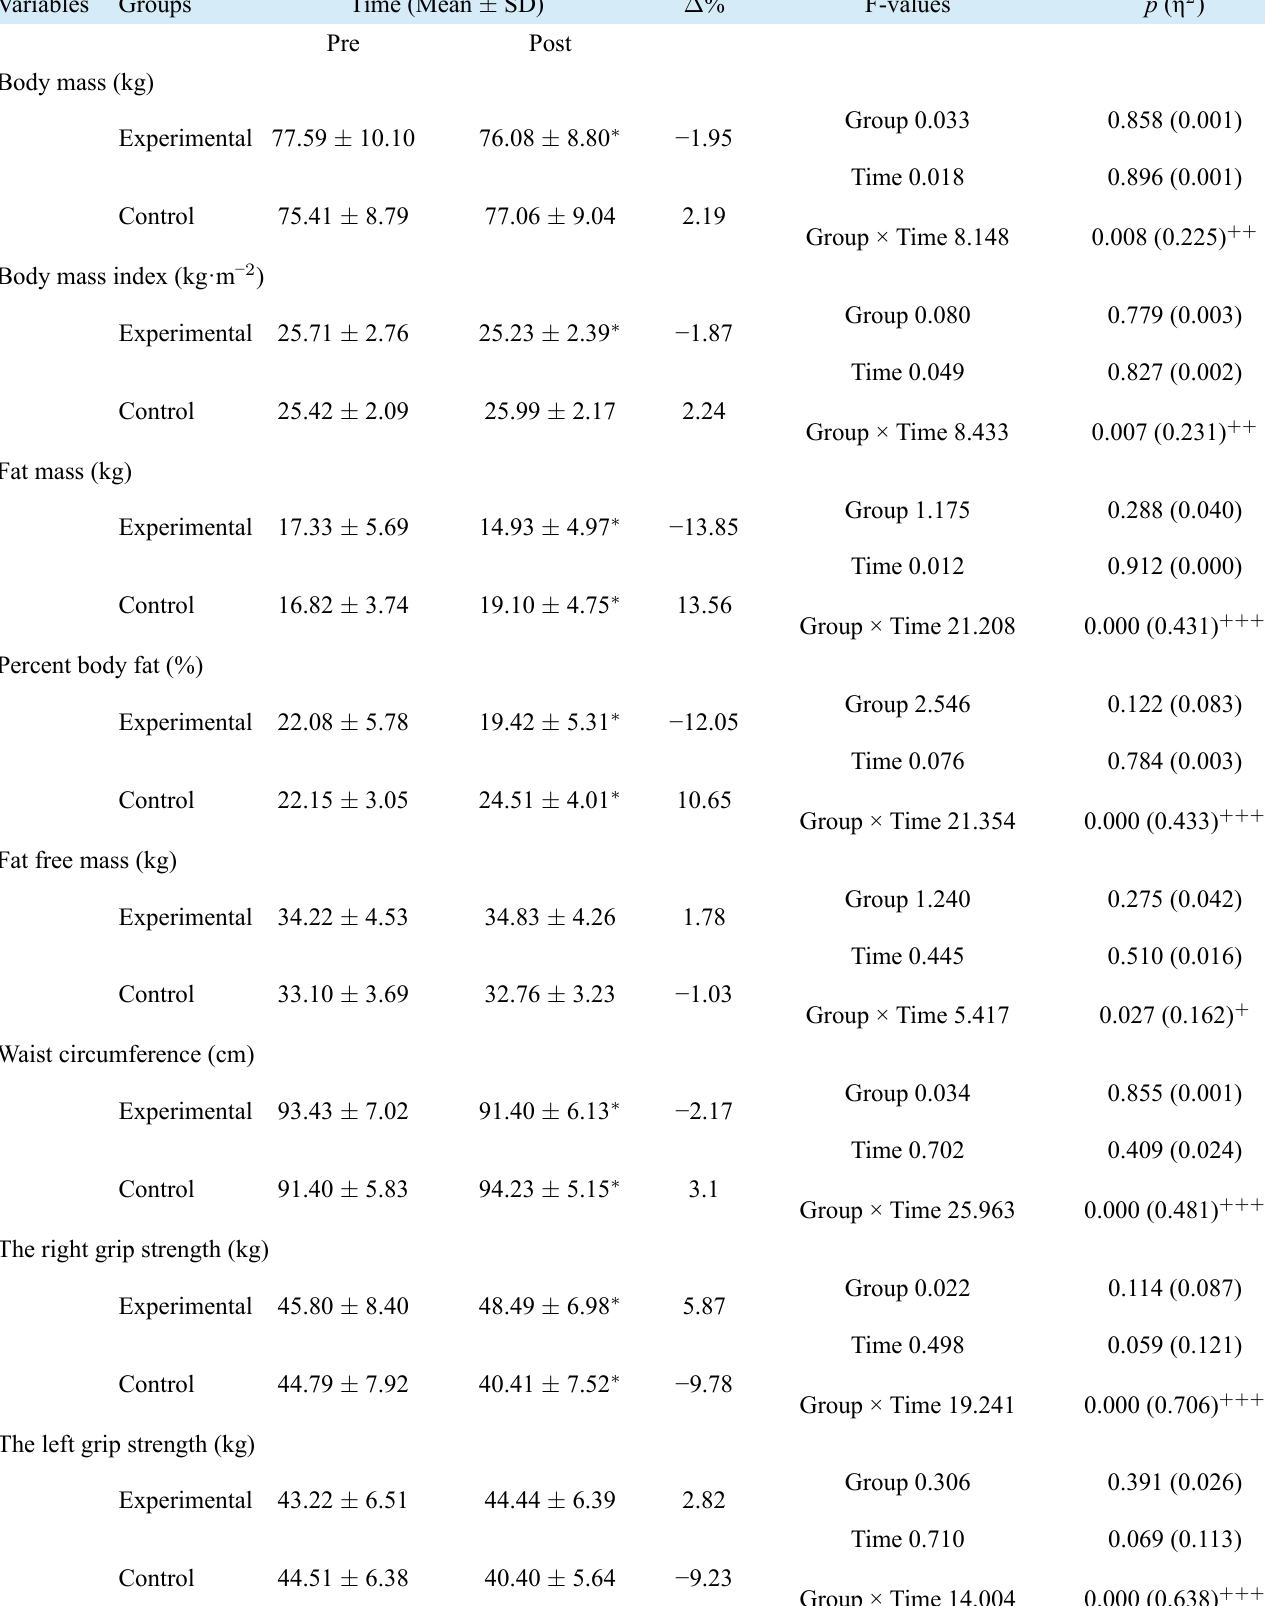
TABLE 3. Body composition and muscle